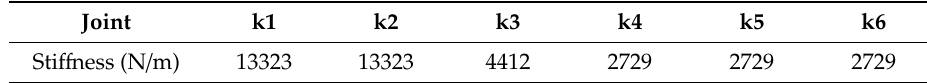
Table 5. Sti ff ness joint